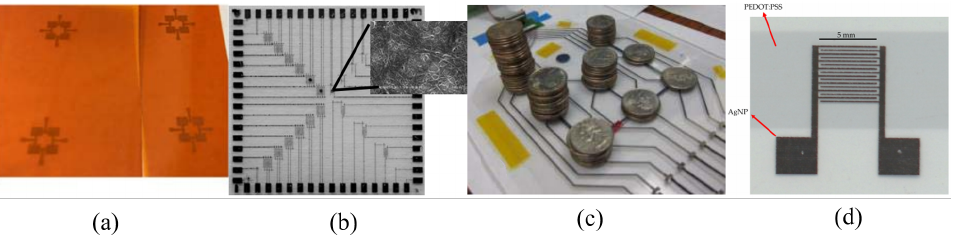
Figure 3. Printed sensors: ( a ) temperature sensors showing transparent property PEDOT:PSS (Reprinted with permission from [50]. Copyright 2020 IEEE); ( b ) a CNT gas sensor array; ( c ) a resistive pressure sensor array with test weights (Reprinted with permission from [13]. Copyright 2017 IEEE); ( d ) a PEDOT:PSS based temperature sensor with silver nanoparticle electrodes (Reprinted from [49] under CC BY 4.0